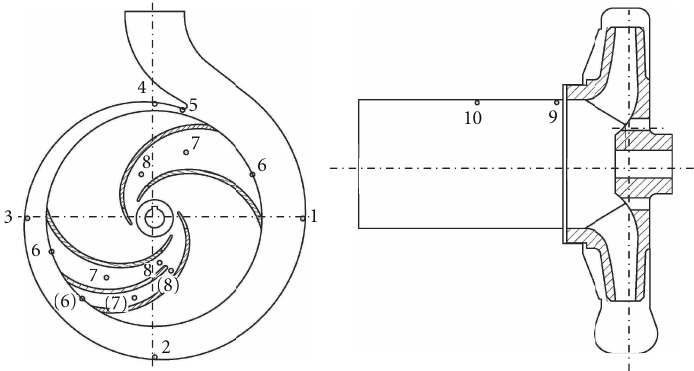
Figure 4: Location of pressure monitoring points.